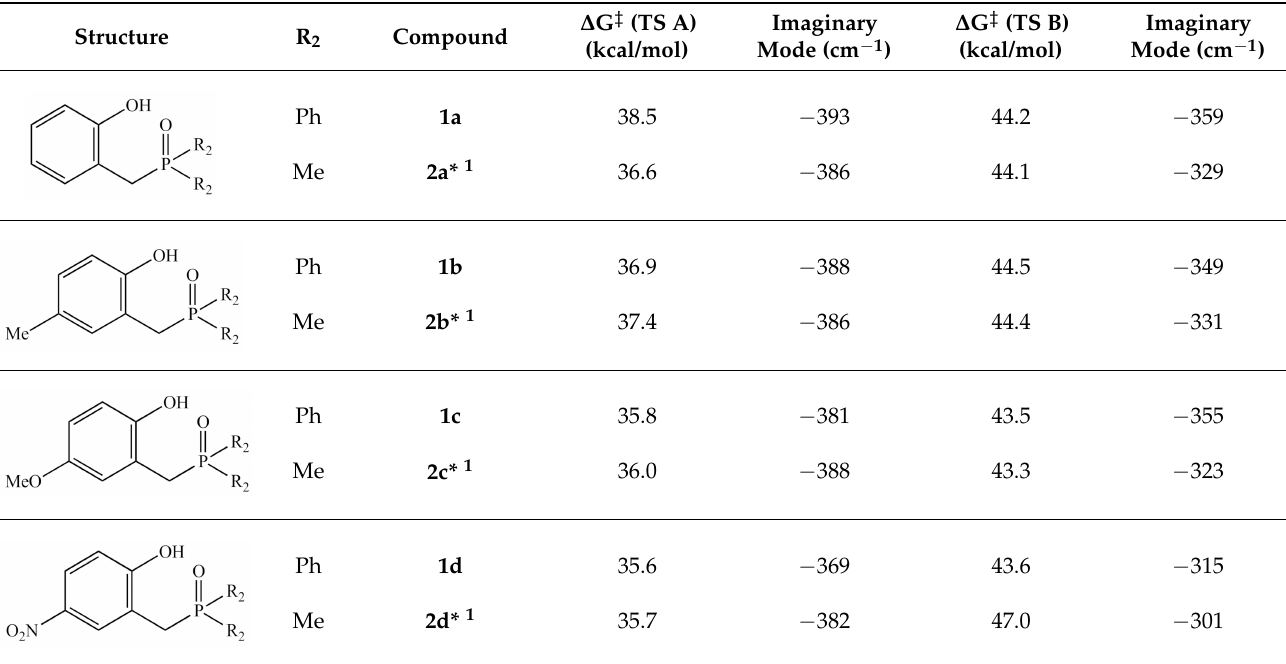
Table 2. Library of 2-HOBPOs examined computationally, with energetic spans reported as ∆ G ‡ vs. GS B , and accounting for liberated water and 1-phenylpropan-2-ol. Structure